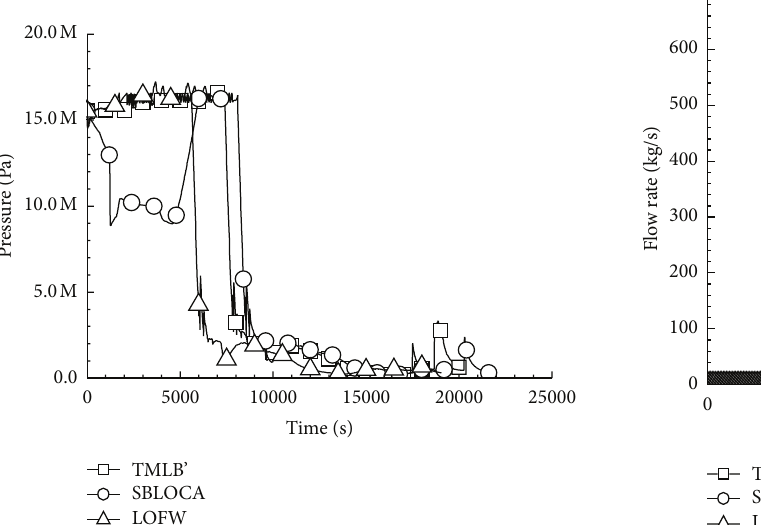
Figure 8: Flow rate of accumulator with activation of